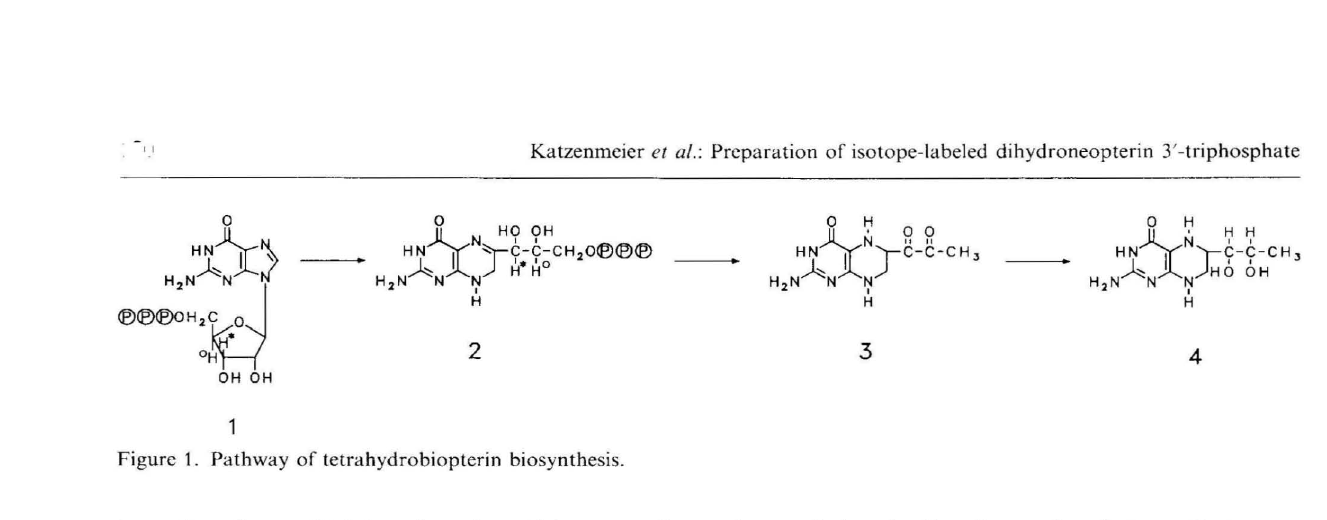
Figure 1. Pathway of telrahydrobiopterin